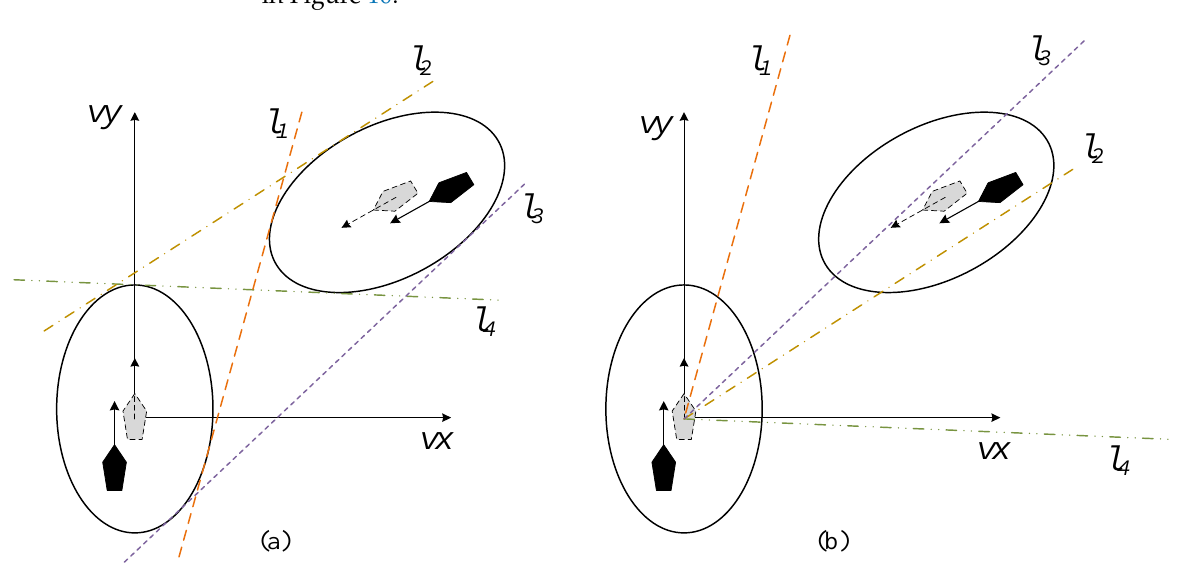
Figure 10. Avoidance in the elliptical ship domain: ( a ) determination of common tangents, ( b ) con- struction of VO cones. ( b ) construction of VO